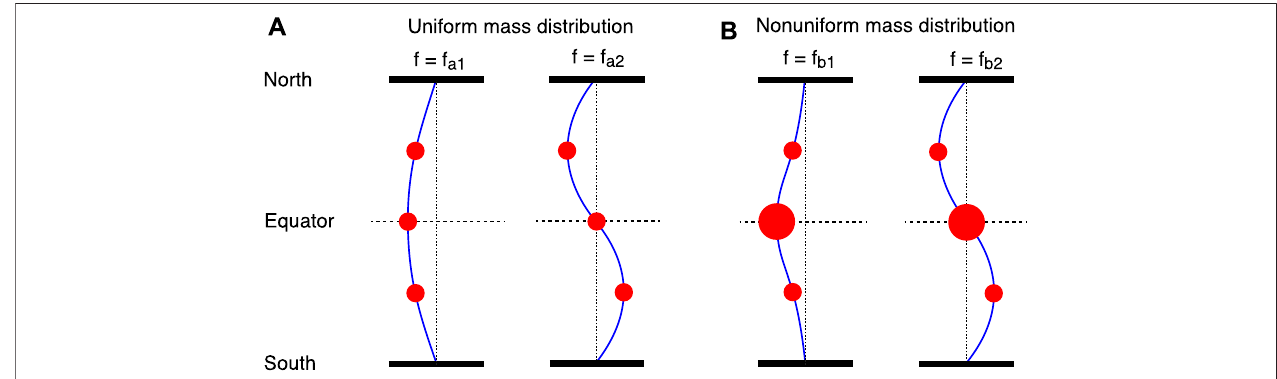
FIGURE1| Stringanalogyofstanding Alfvénwaves. The bluecurvesrepresent the fi eld line,and the sizeofthe fi lled red circles representsthemassdensity value. The string is tied at the northern and southern ends corresponding to the ionospheric footpoints of the fi eld line. (A) Structure of the fundamental (left) and second harmonic (right) modesforthecaseofauniformmassdensitydistributionalongthe fi eldline.Thenodeorantinodeislocatedattheequator(horizontaldashedline).The mode frequencies are denoted f a1 and f a2 . (B) Sameas (A) but for a mass density distribution that is peaked at the equator. The mode frequencies are denoted f b1 and f b2